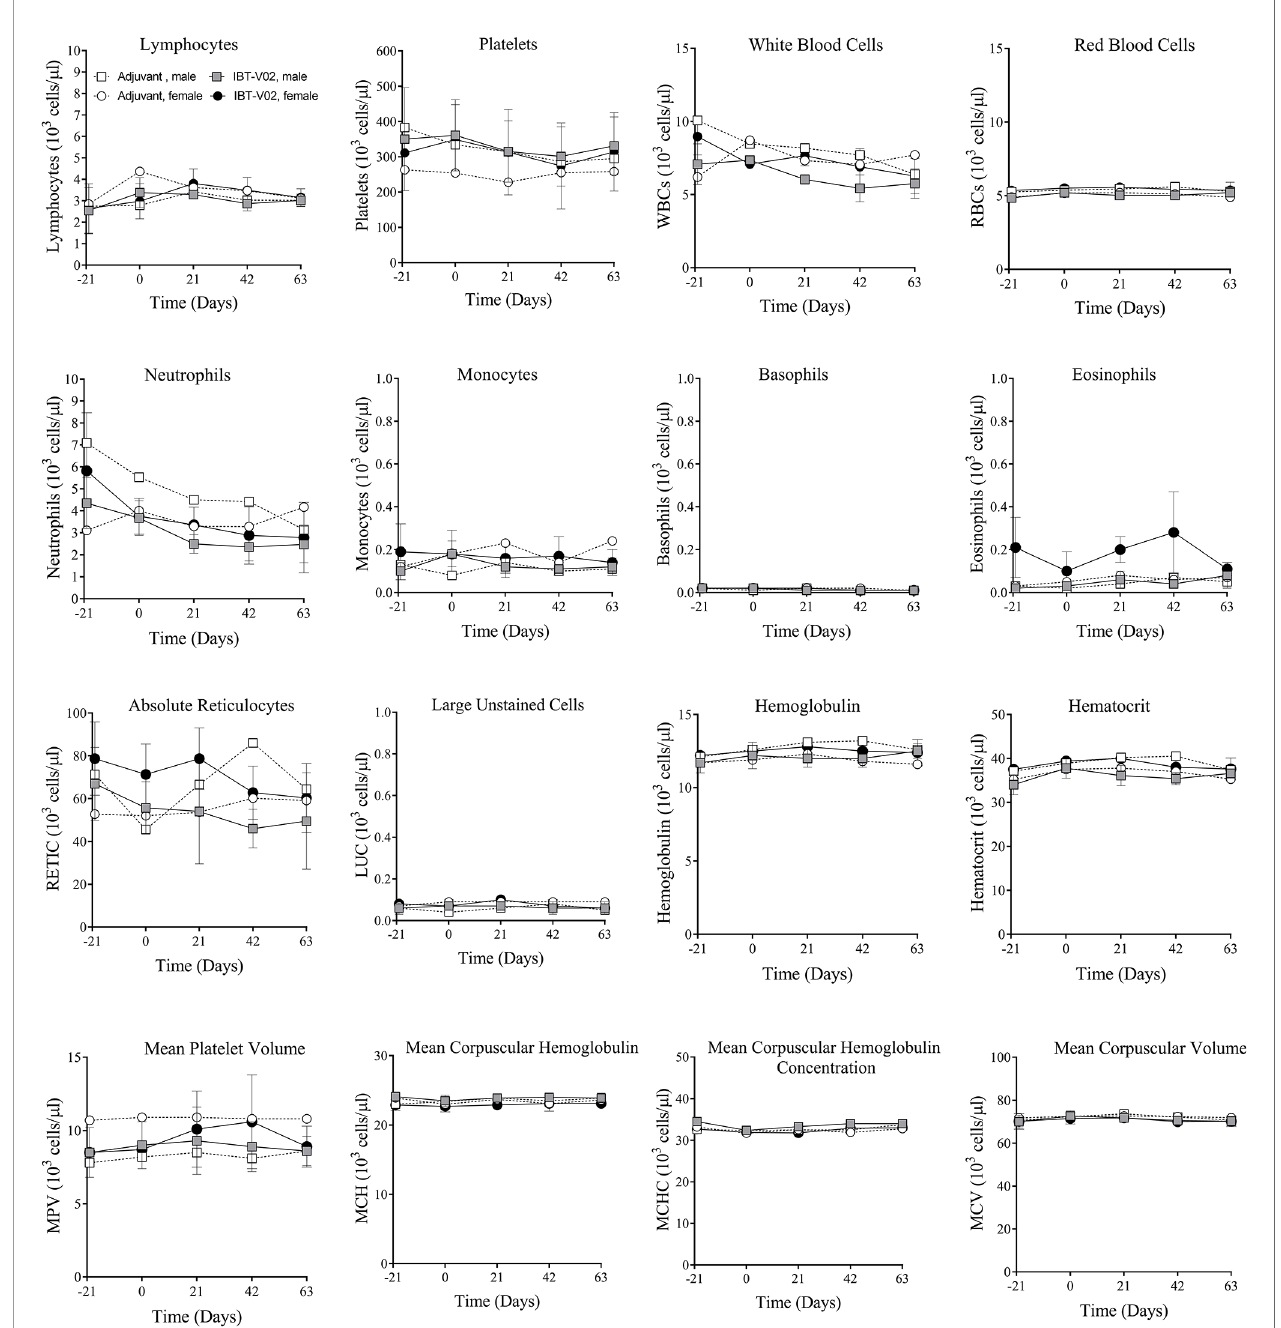
FIGURE 2 | Hematology. Hematology data of non-human primates (NHPs) measured in serum samples collected on day 21 (D-21) and on day 0 (D0) prior to vaccination, and on days 1 (D1), 21 (D21), 42 (D42), and 63 (D63) after vaccination. Data was analyzed with GraphPad PRISM